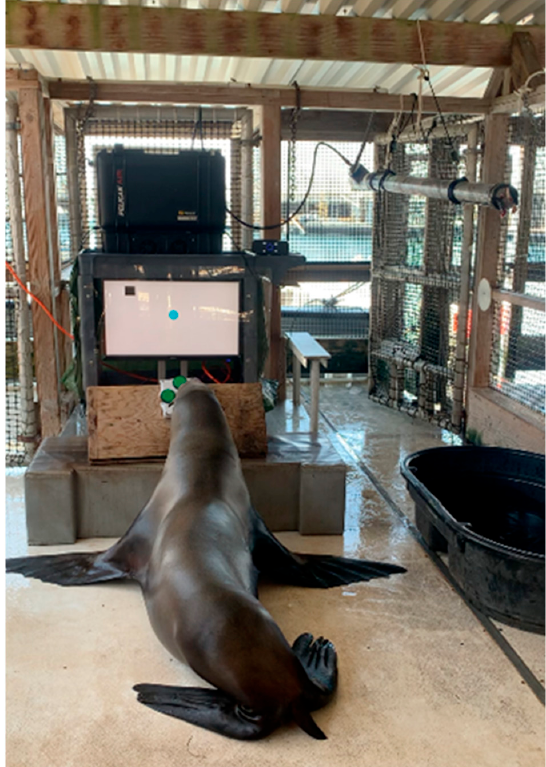
Figure 1. A sea lion playing CTG during a session in which reinforcement is provided by the automated feeder. When the sea lion is successful, the program communicates to an Arduino that is connected to a pressurized air tank, which pushes water into the cylinder and moves a piston forward, releasing pieces of fish and ice.